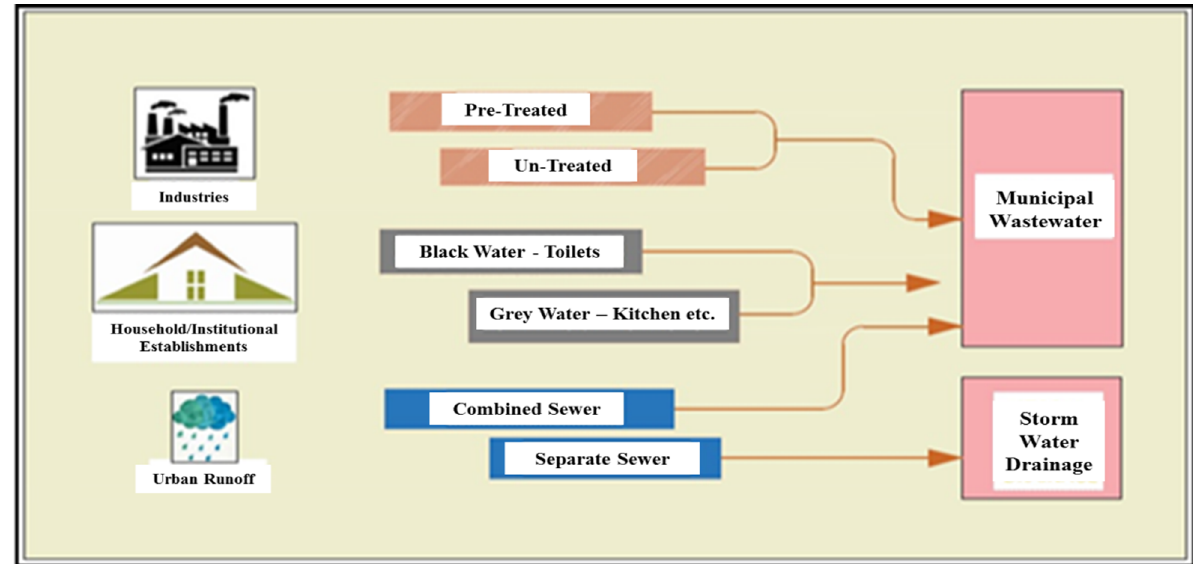
Figure 1. Different sources, i.e., industrial, domestic, and urban runoff; types of wastewaters; and their potential reuse modified from Reference [46].